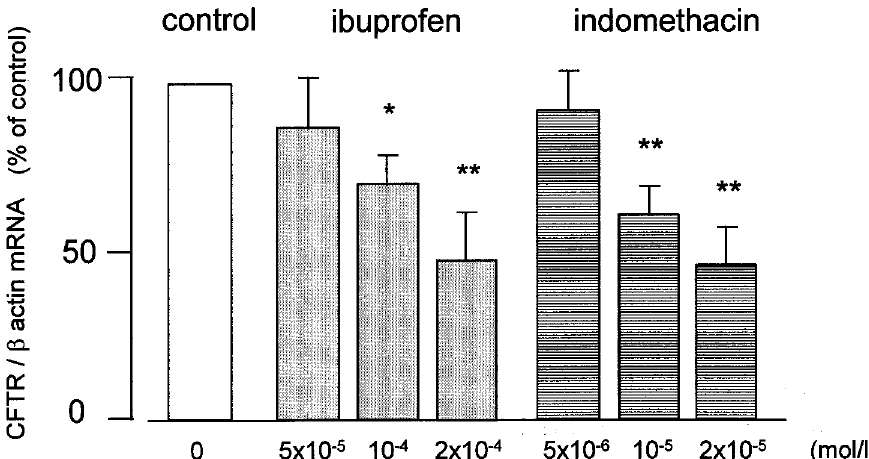
FIG. 5. Concentration dependence of the decay of CFTR transcripts induced by ibuprofen and indomethacin. Northern blots were performed using 15 m g total RNA extracted from cells treated for 24h with various concentrations of ibuprofen and indomethacin. The cell content in CFTR mRNA is normalized to the content in b -actin mRNA, and the results are expressed as a percentage of the ratio determined on control cells. * P <0.05; ** P <0.01 ( n =